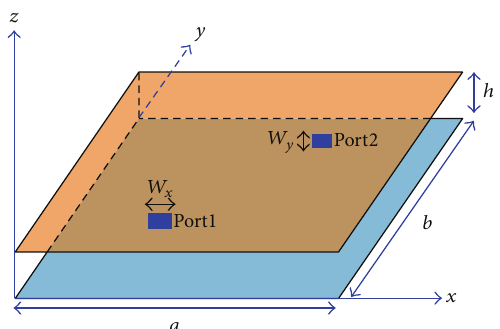
Figure 2: Integrated rectangular plane